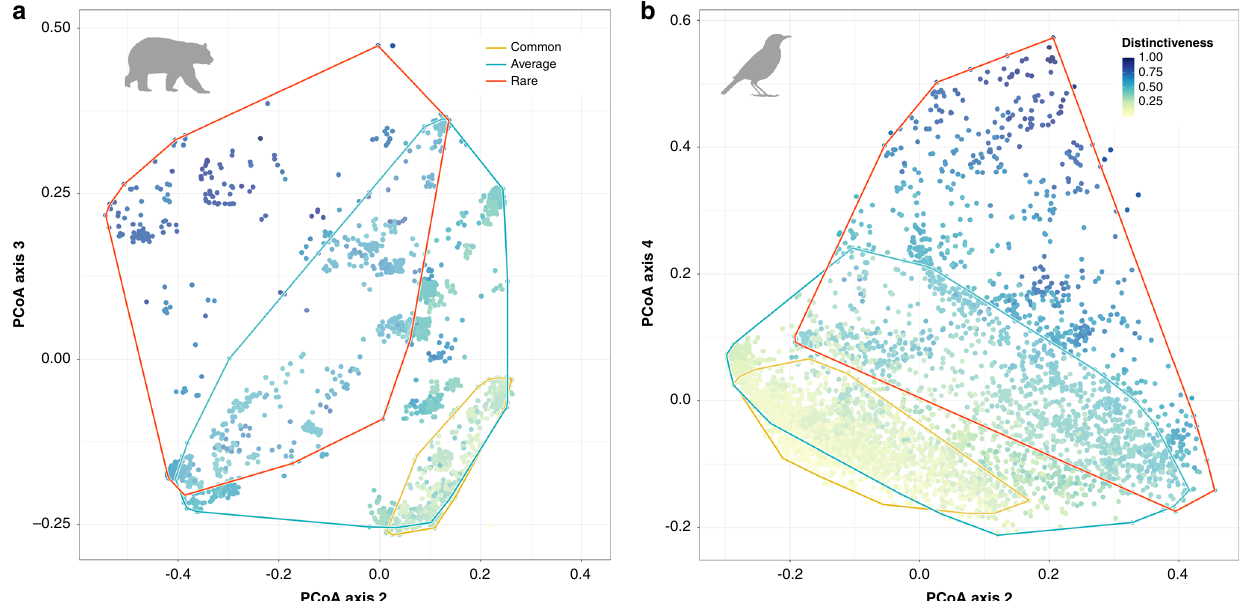
Fig. 2 Ecologically rare fi ll a wide breadth of ecological strategies in the Eltonian niche space. Principal Coordinates Analysis (PCoA) representing the functional space of mammals ( a ) and birds ( b ) based on their functional traits. The two axes (PC2 and PC3 for mammals, PC2 and PC4 for birds,) explain respectively 35.3% and 26.4% of the variance in the distance matrix (see Supplementary Tables 1 and 2). Species are colored by their functional distinctiveness values. Functional space of ecologically rare species is in red, common, and average species are respectively in orange and blue. Icons were generated using R ( rphylopic package) and are under a public the Public Domain Dedication 1.0 license.